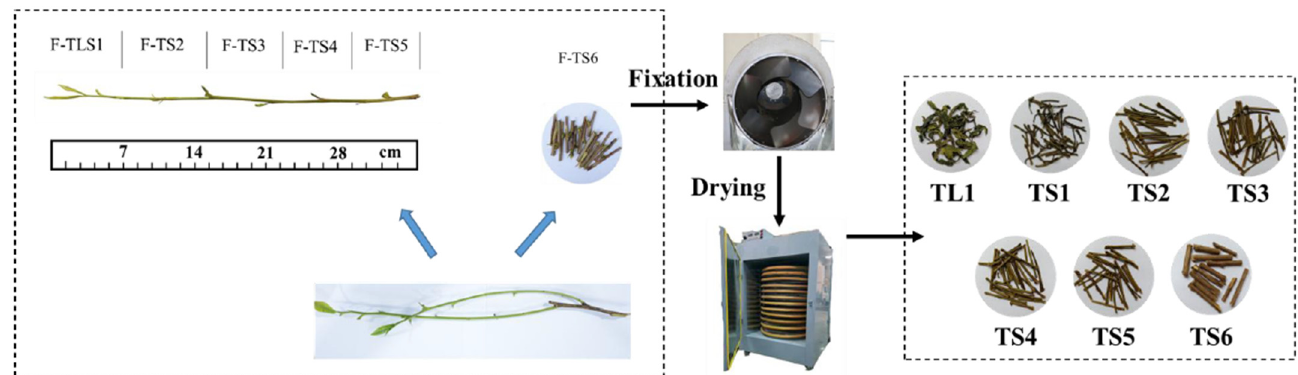
Figure 1. Processing of tea leaf and stem samples.